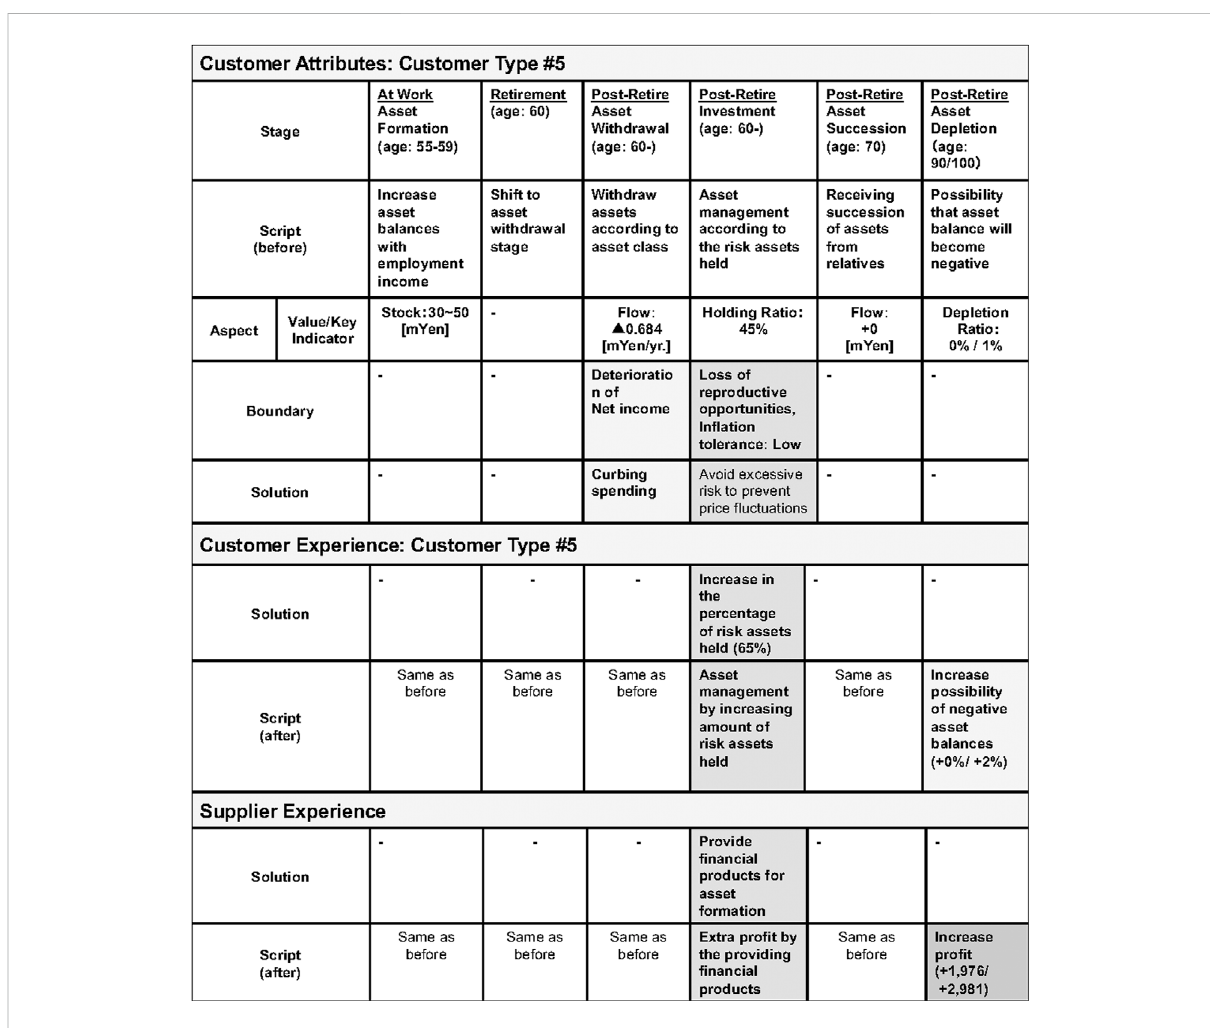
FIGURE 11 Simulation results described with extended SEBM (Customer type: